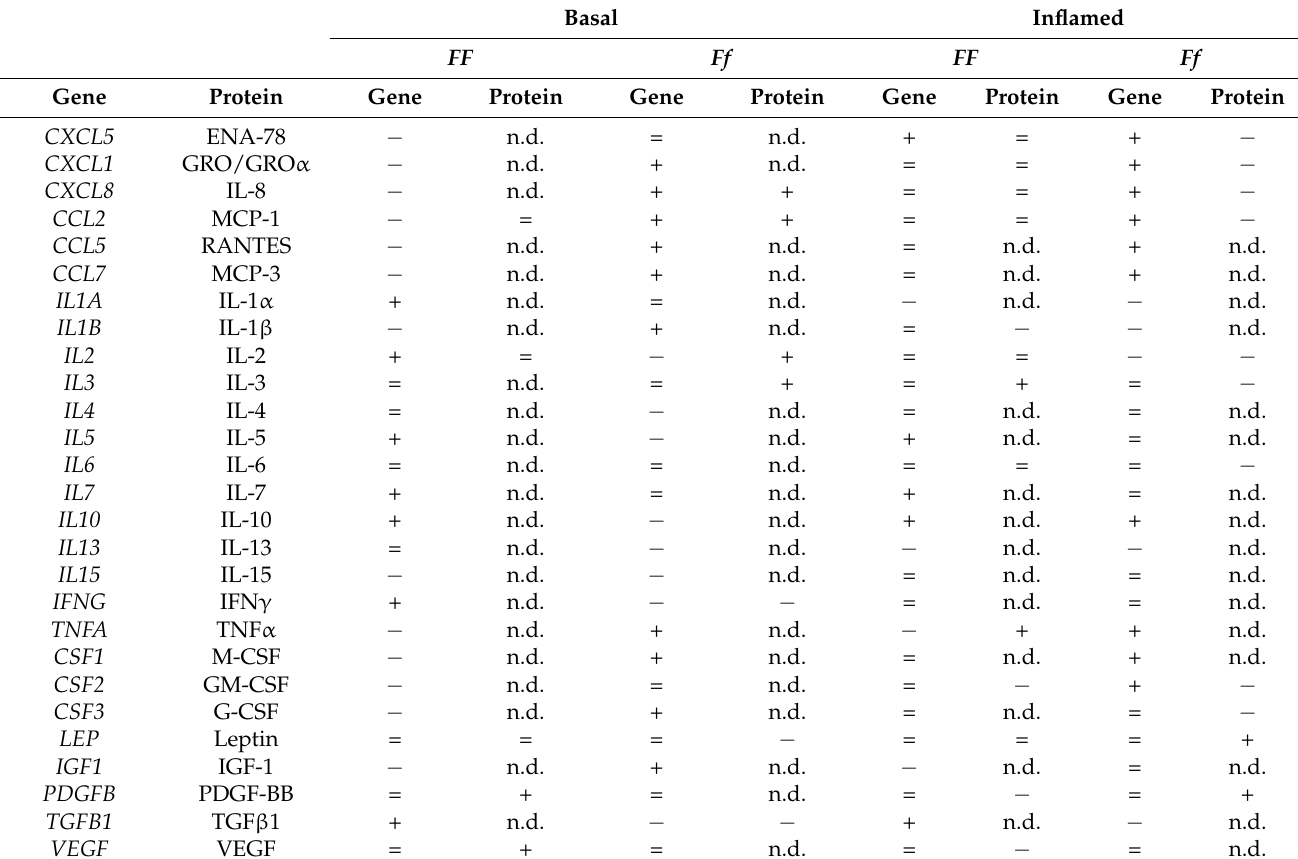
Table 1. Protein array and expression of their encoding genes in disc cells depending on the presence of FokI receptor variants after vitamin D treatment in basal and inflamed